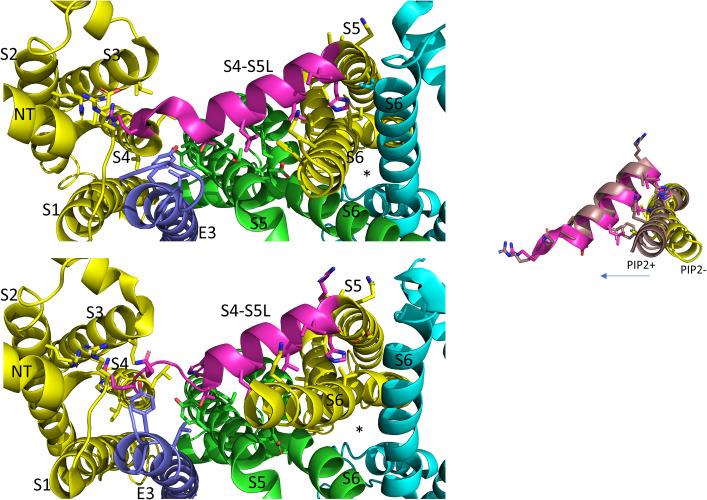
In the PIP2 bound state the KCNQ1 S4-S5L appears to have pivoted out and S6 has expanded into the space vacated. View is from below. Each of three subunits of the tetramer is shown in a different color. The S4-S5L of the yellow subunit is shown in magenta for emphasis. The PIP2-free structure of hKCNQ1/CaM/KCNE3 is on top (6V00) and the PIP2-bound structure is on the bottom (6V01). The asterisks indicate the location of the inner vestibule. Most of the intracellular portions and transmembrane regions of the other subunits have been removed for clarity. Inset: overlay of just the linker and the covalently linked S6 subunit, in PIP2 bound and unbound states highlighting changes related to PD opening. Arrow points in direction of expansion. Image made from pdbs 6V01 and 6V00 (Sun and MacKinnon, 2020) using PyMOL software (The PyMOL Molecular Graphics System, Version 2.2.3 Schrödinger, LLC).